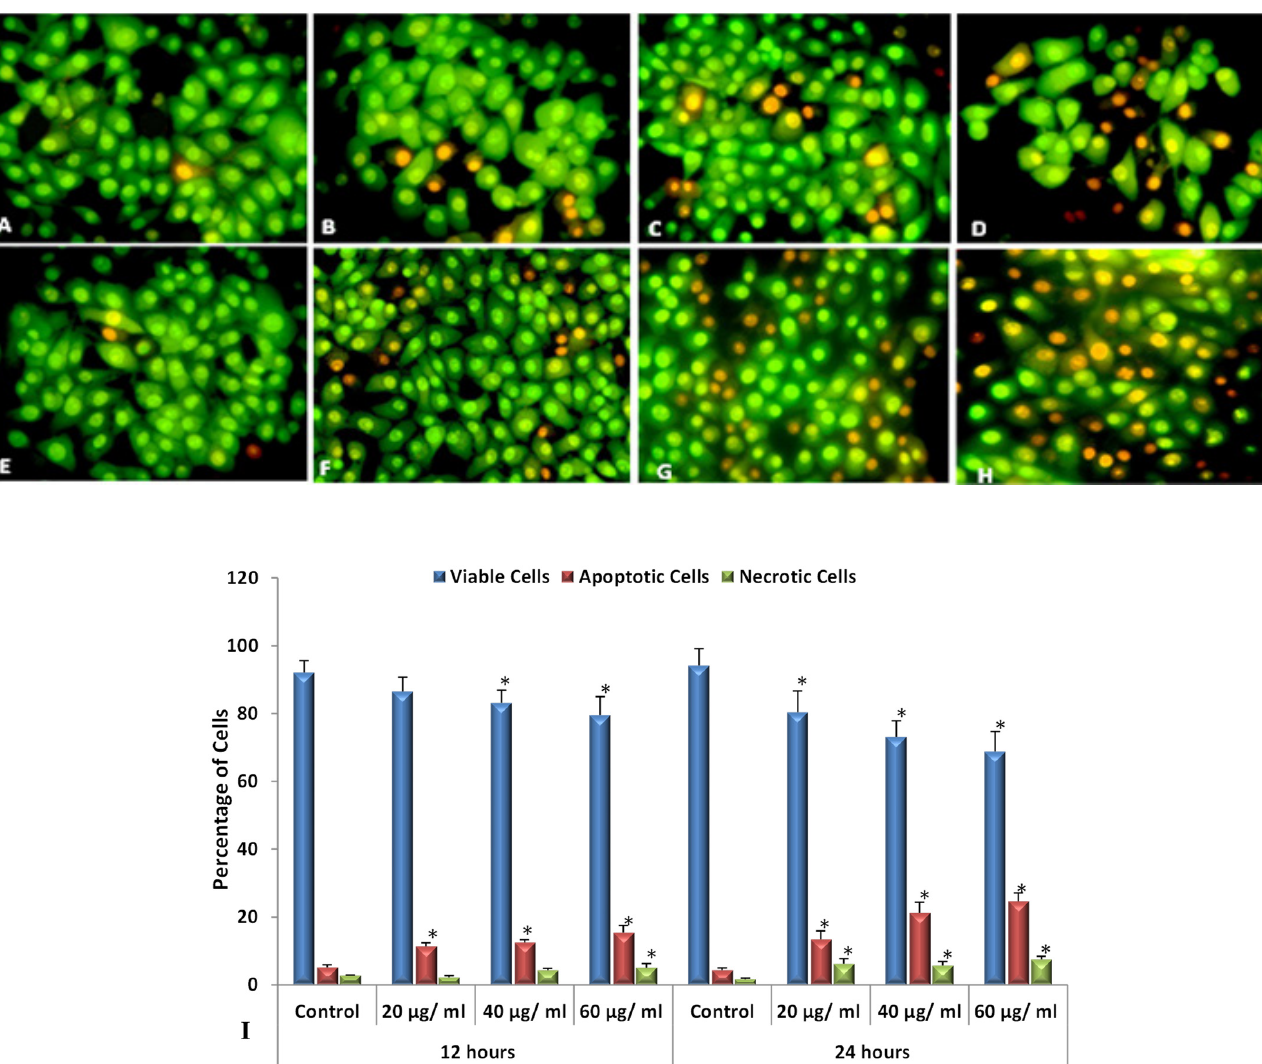
Figure 9. Assessment of apoptotic morphological changes by (acridine orange-ethidium bromide) dual staining method. Representative images of untreated control cells ( A , E ) and cells treated with 20 µg/mL ( B , F ), 40 µg/mL ( C , G ), and 60 µg/mL ( D , H ) of SMAgNPs after 12 h ( A – D ) and 24 h ( E – H ), respectively (magnification 40 × ). Quantitative evaluation of HepG2 cells revealed apoptotic alteration increased in dose- and time-dependent fashion ( I ). Data are presented as mean ± SD for three independent experiments performed in triplicate (* significant, p < 0.05).